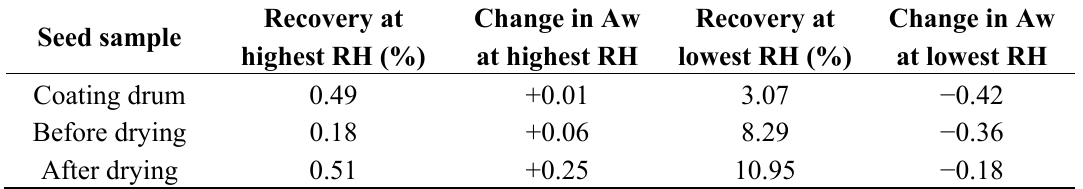
Table 3. Recovery of RRI128 from M. sativa seed after 9 weeks storage at high and low relative humidity (RH) and corresponding change in water activity. Values were calculated using cell numbers and water activities at 16 days and 9 weeks after